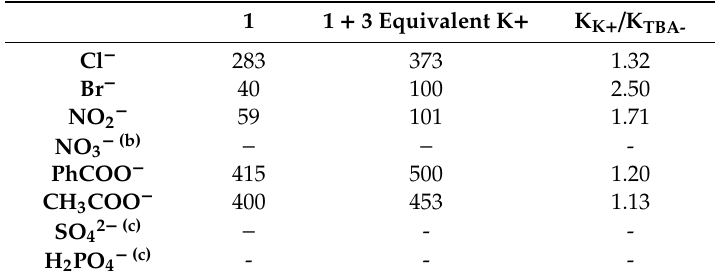
Table 1. Association constants (Ka) for interactions between receptor 1 and selected anions in the absence or presence of 3 equivalent of KPF 6 (a) .